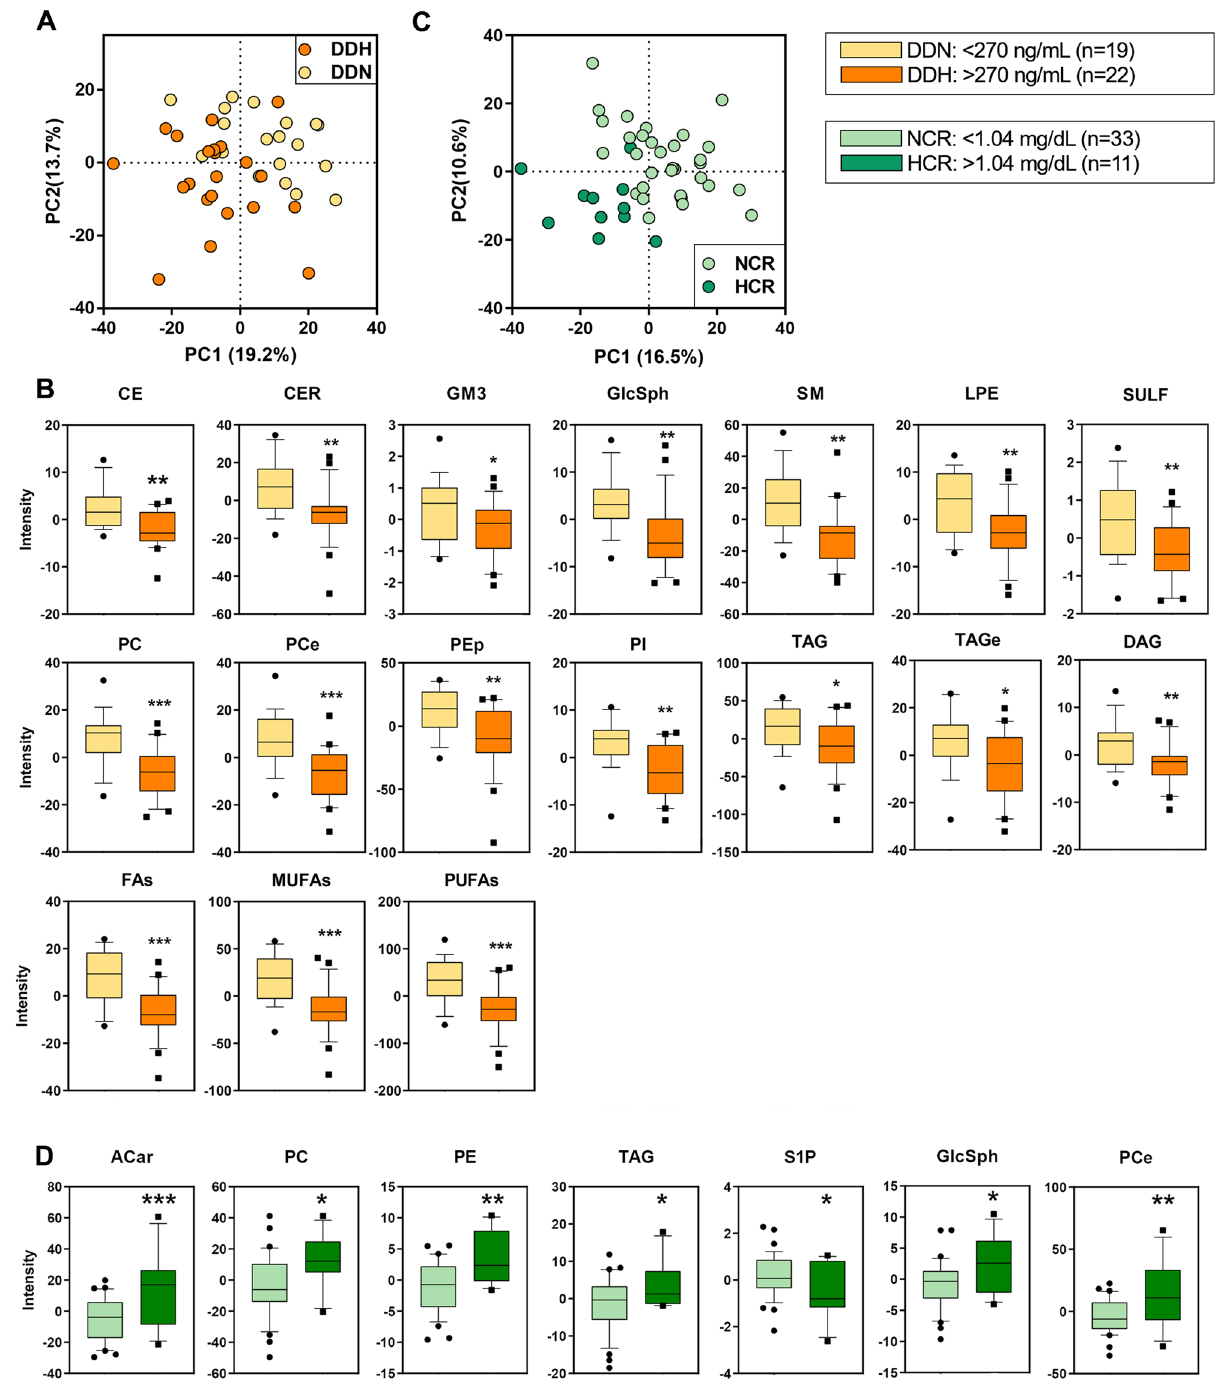
Figure 2. Discriminant analysis (score plot) of the lipidome as a function of coagulation ( A ) and kidney function ( C ). Only lipid classes with a statistical significance are shown in boxplots in function of increasing in D-dimer ( B ) and creatinine ( D ) concentrations. Boxes: 25th–75th percentiles; lines: 10th–90th percentiles; crossing lines: median values; separate points: outliers. Statistical tests were performed by univariate